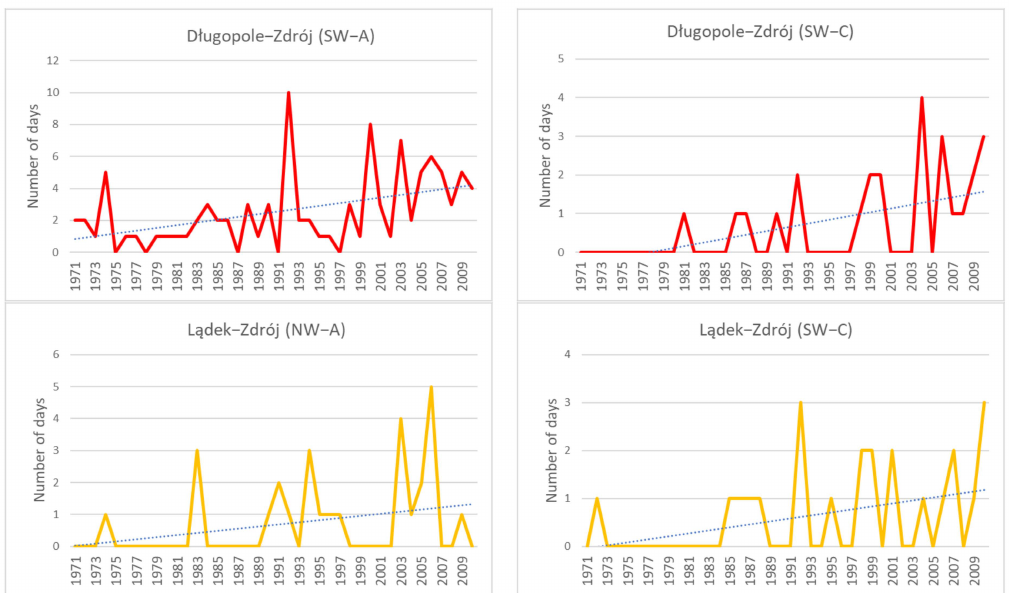
Figure 7. Changes in the number of days with UTCI > 32 ◦ C in Długopole-Zdr ó j under SW-A and SW-C circulation (top) and in L ˛adek-Zdr ó j under NW-A and SW-C circulation (bottom) in 1971–2010.